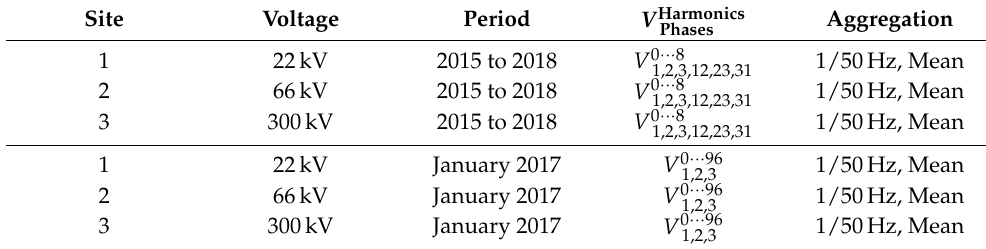
Table 1. We extract two data packages. The first covers four years, six voltage channels, eight harmonics. The second covers a month, three voltage channels, 96 harmonics. They contain 3.6 × 10 11 and 3.9 × 10 10 samples, respectively. Site Voltage Period V Harmonics 1 22kV 2015 to 2018 V 0 ··· 8